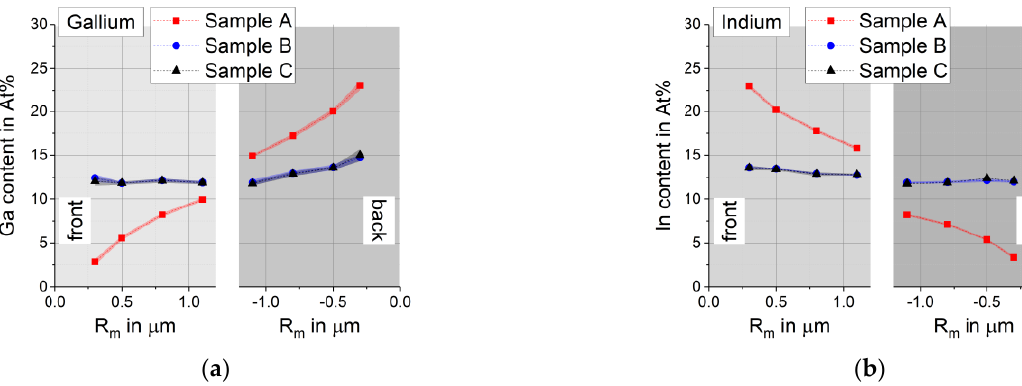
Figure 7. EDX with different acceleration energies measured from the front and the back. Points give the average between 12 different locations and shaded area represents the standard deviation: ( a ) Ga gradient; ( b ) In gradient.